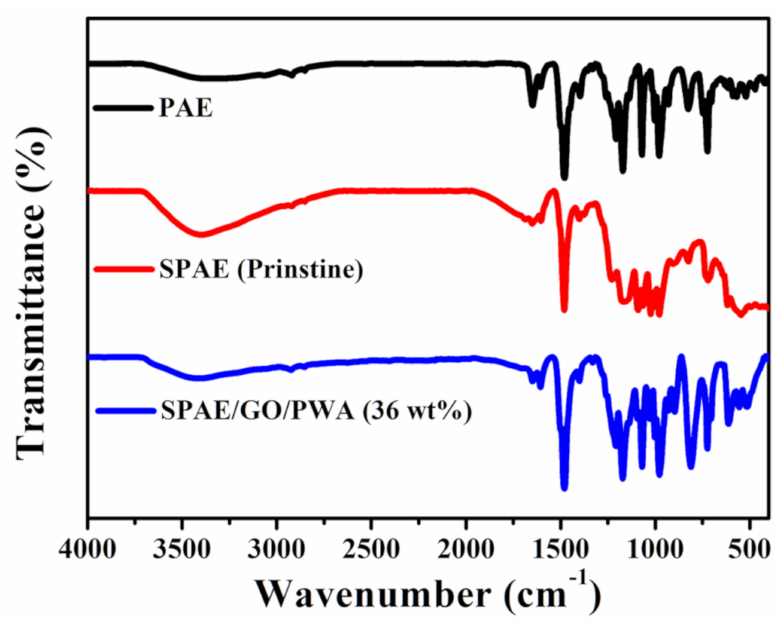
Figure 3. FT-IR spectra of PAE, SPAE, and SPAE/GO/PWA 36 wt%.